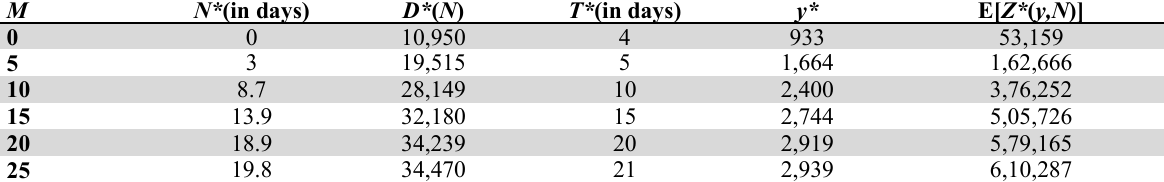
Impact of M on optimal production policy (in the presence of 2 stage trade